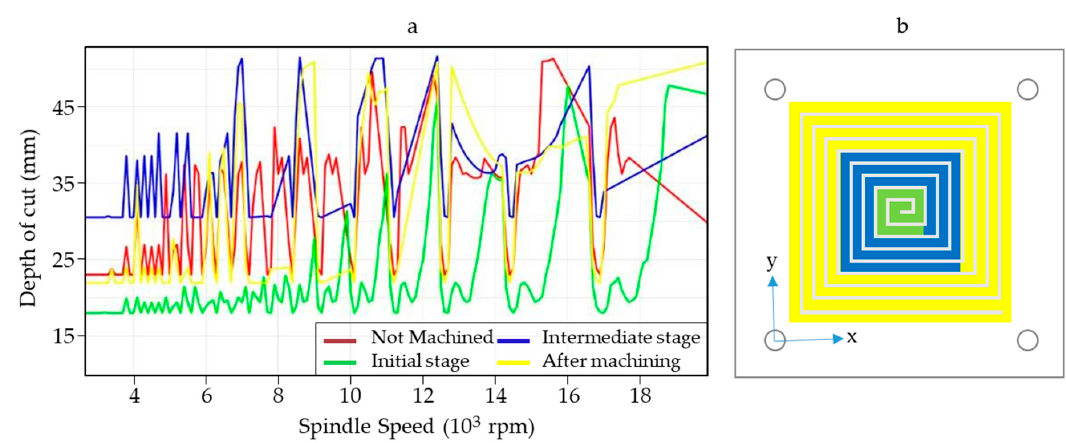
Figure 6. ( a ) Stability Lobe Diagrams (SLD) variation depending on the machining stage. Red line, before the machining; green line, in the first instants of the machining; blue line, intermediate stage;